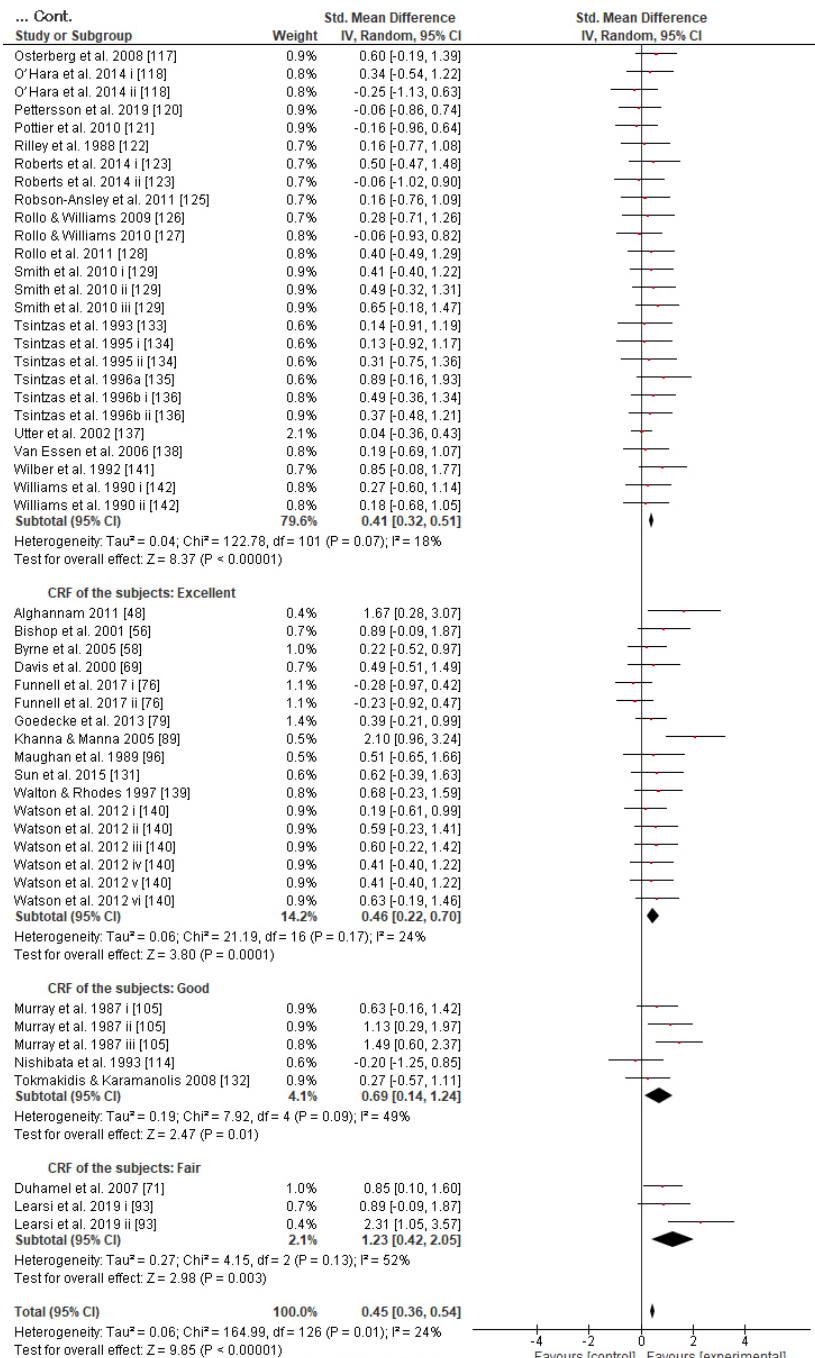
Figure 3. Forest plot shows the effects (red square symbol) of experimental carbohydrate supplementation as compared to a control on exercise outcome for 127 interventions [47–52,54–65,67–74,76–105,109–118,120–123,125–129,131,133–142]. Subgroup analyses show the re- sults with regards to subjects’ characteristics in four CRF groups (superior, excellent, good, and fair). The black diamond symbol at the subgroups and at the bottom of the figure represents the standard- ized mean difference with the 95% confidence intervals for all interventions following random effects meta-analyses. Studies or trials that provided insufficient data for subgroup classification were not included. Abbreviations: CI, confidence interval; CRF, cardio-respiratory fitness; IV, inverse variance; SD, standard deviation; Std, standardized; i–vi denote different intervention arms (trials) within the same